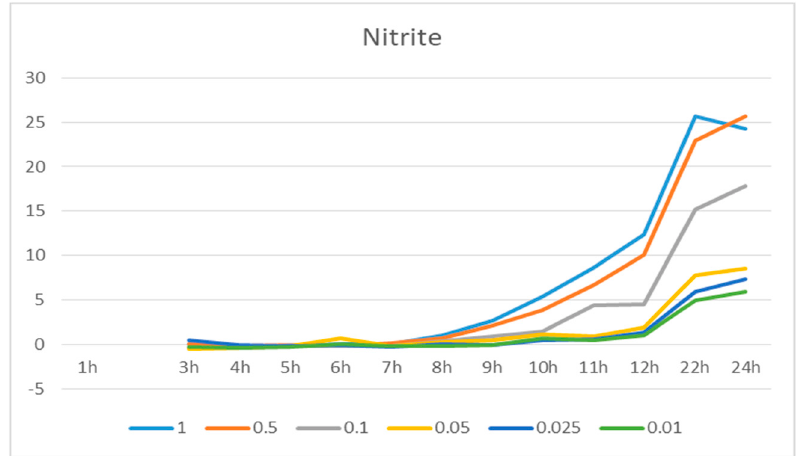
Figure 1. The nitrite concentration ( μ M) tested at different times with stimulation of different lipopolysaccharide (LPS) doses. Different colors correspond to the different concentrations of LPS (from 0.01 μ g/mL to 1 μ g/mL).